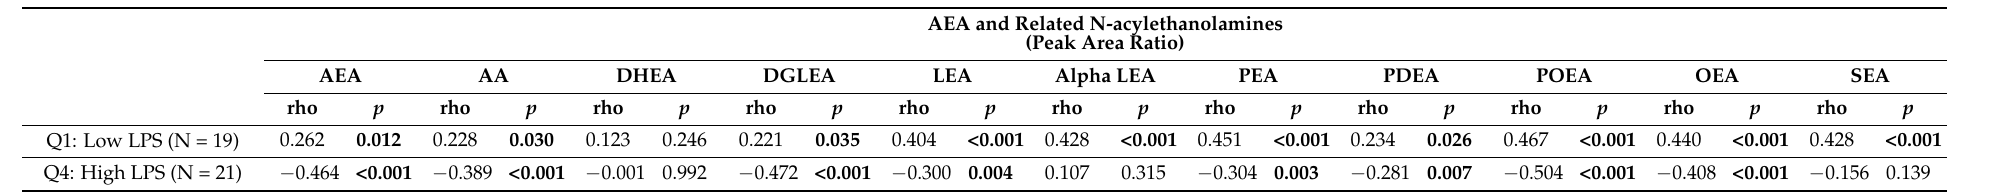
Table 3. Partial Spearman correlation of plasma levels of AEA and related N-acylethanolamines with plasma levels of lipopolysaccharide in participants who showed very low and high values (EU/mL) adjusted for body mass index.